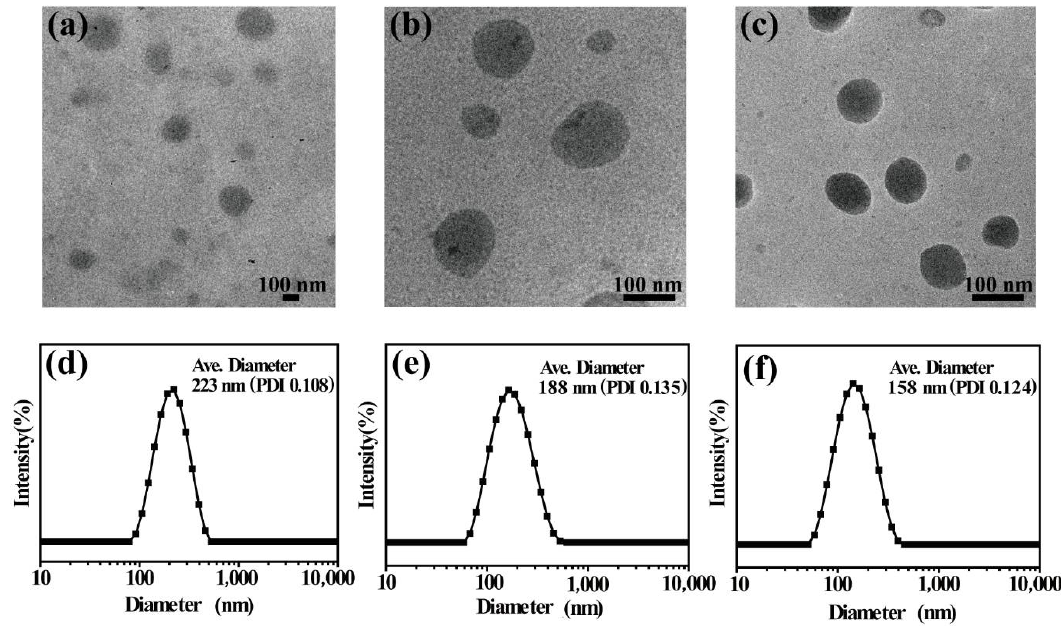
Figure 1. TEM images and DLS curves of BCP1 ( a , d ), BCP2 ( b , e ) and BCP3 ( c , f ) micelles.